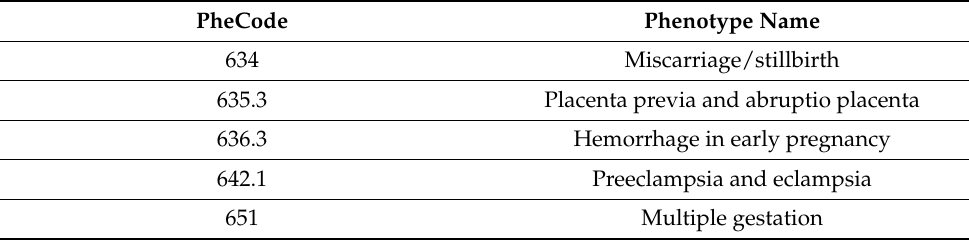
Table 1. A sample of obstetric disorders under consideration in our